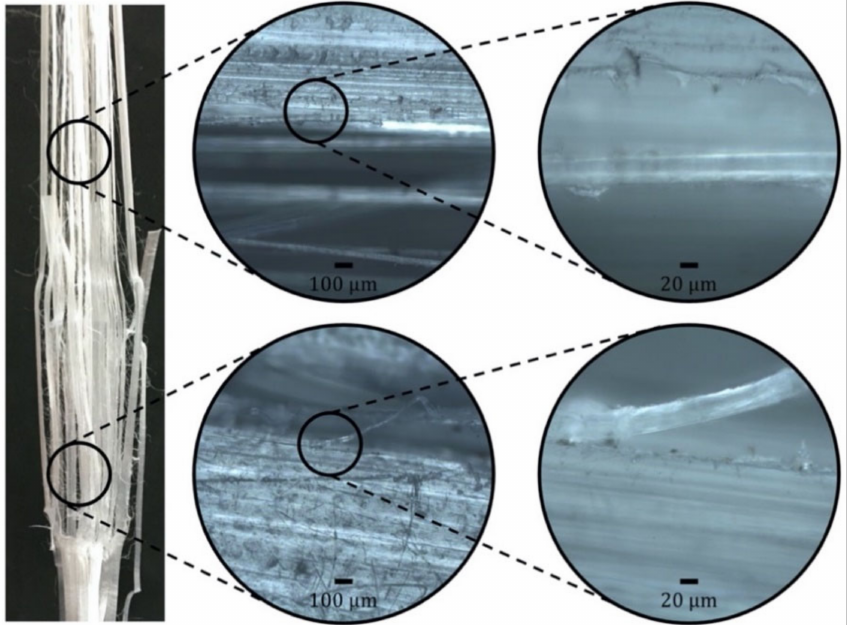
Figure 10. Typical debonding-induced longitudinal failure outside ( top ) and within ( bottom ) the